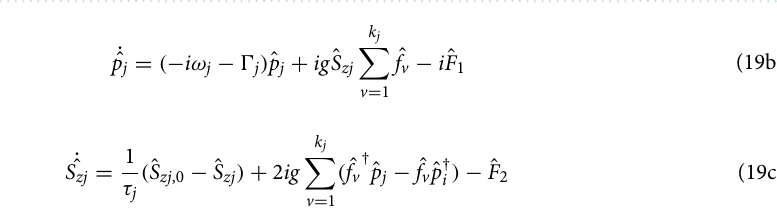
Figure 3. Sketch of ( a ) physical and ( b ) social laser systems, respectively. The processes, which are allowed in the solaser for TLS representing agent of DM, are shown in ( c ). The model of physical laser presumes interaction of resonator modes (only one mode is shown) with the ensemble of two level-oscillators (atoms) in the presence of an optical pump. At the core of solaser there is an echo chamber, which provides circulation and amplification of some privileged mode for the s-information field in a social network (illustrated with the red directed edges) in the presence of a strong social mass media pump. In ( c ) excited states,